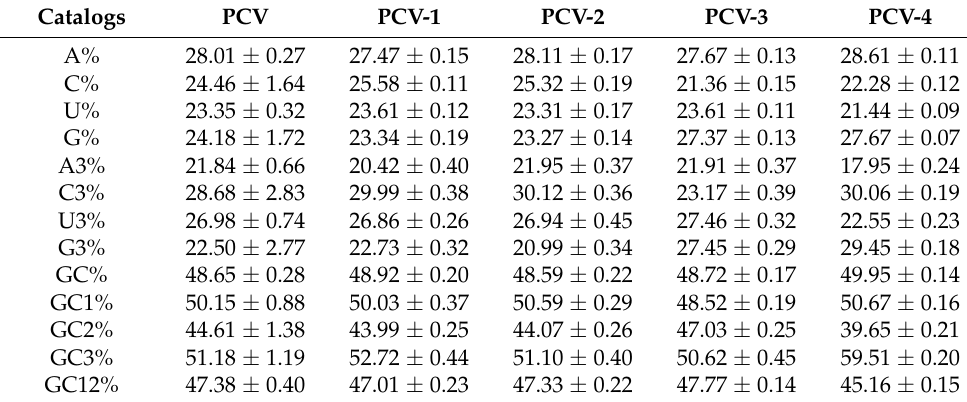
Table 1. Composition analysis of the selected sequences of PCVs.